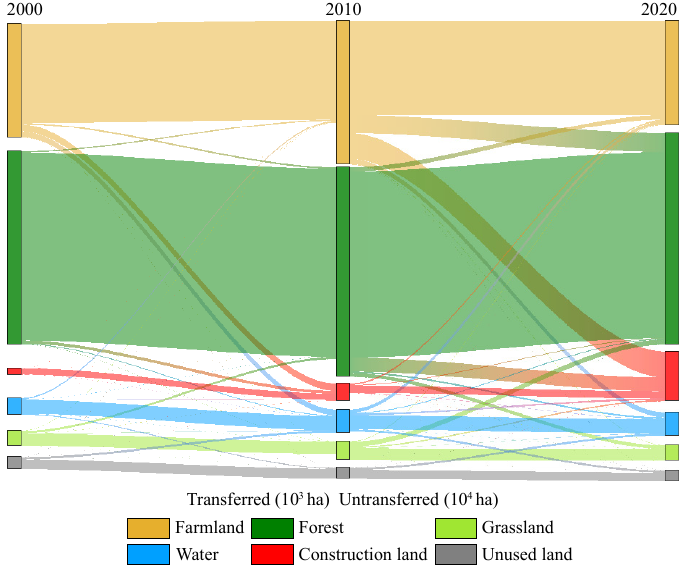
Figure 4. Characteristics of land-use transition in the Middle Reaches of the Yangtze River from 2000 to 2020. Table 4. Land-use transition in the Middle Reaches of the Yangtze River from 2000 to 2020 (km 2 ).